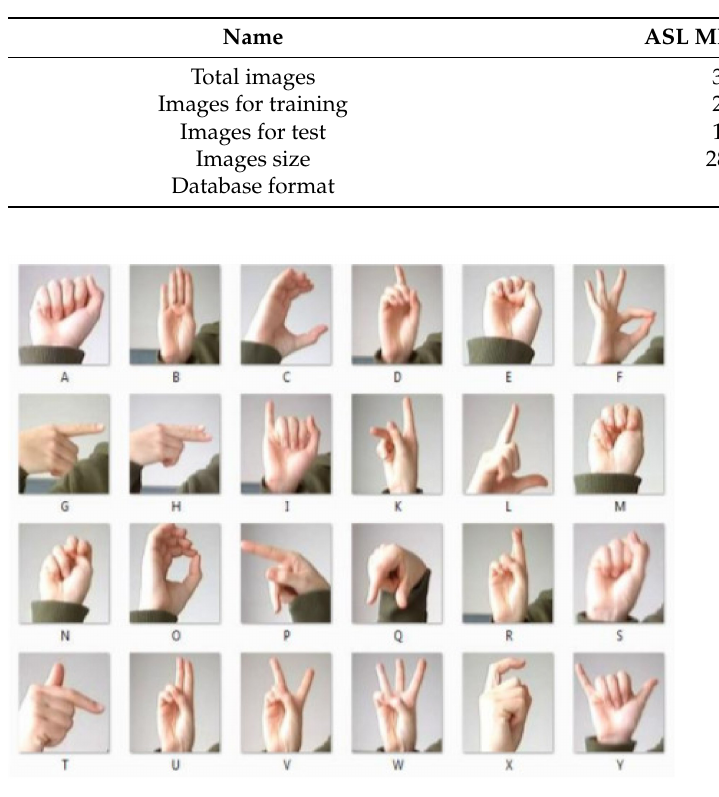
Figure 12. A sample of the ASL MNIST database.